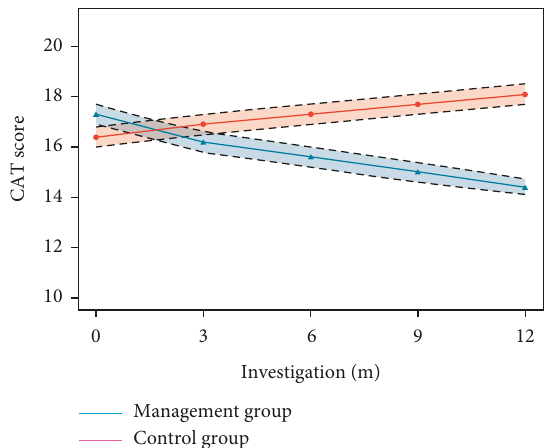
Figure 2: CAT in management group and control group in 12 months.